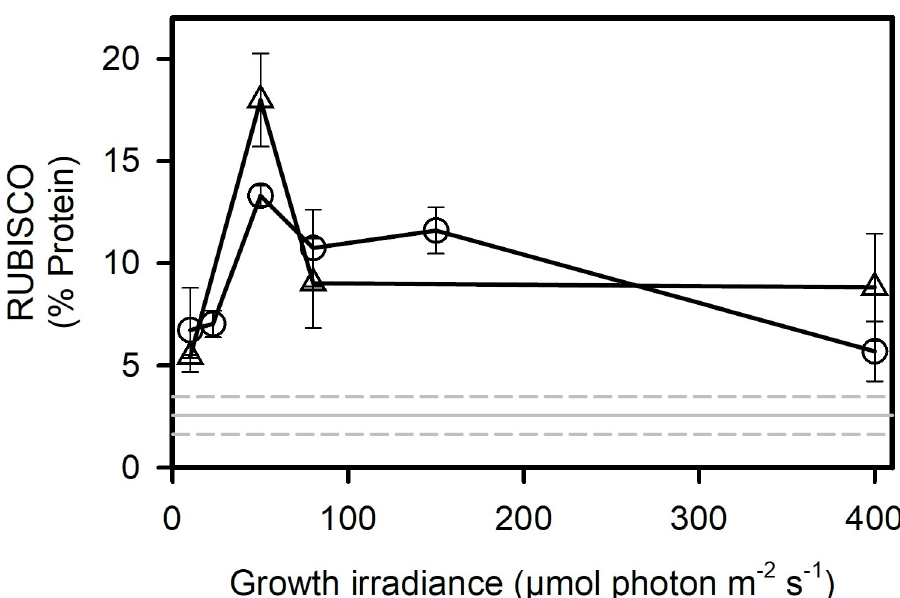
Fig 3. Photoacclimation of the Rubisco content. Rubisco content versus growth irradiance at 0˚C (circles) and 5˚C (triangles). The grey line represents the mean rubisco content measured in various mesophilic diatoms ( Thalassiosira weissflogii , Thalassiosira oceanica , Skeletonema costatum , Chaetoceros muelleri , Phaeodactylum tricornutum from Losh et al. (2013)). Dashed lines represent standard deviations. Each data point is the mean of 3 cultures measured each day during 3 consecutive days (23, 50, 80, 150, 400 μ mol photon m -2 s -1 ) or 2 days (10 μ mol photon m -2 s -1 ). Error bars represent standard